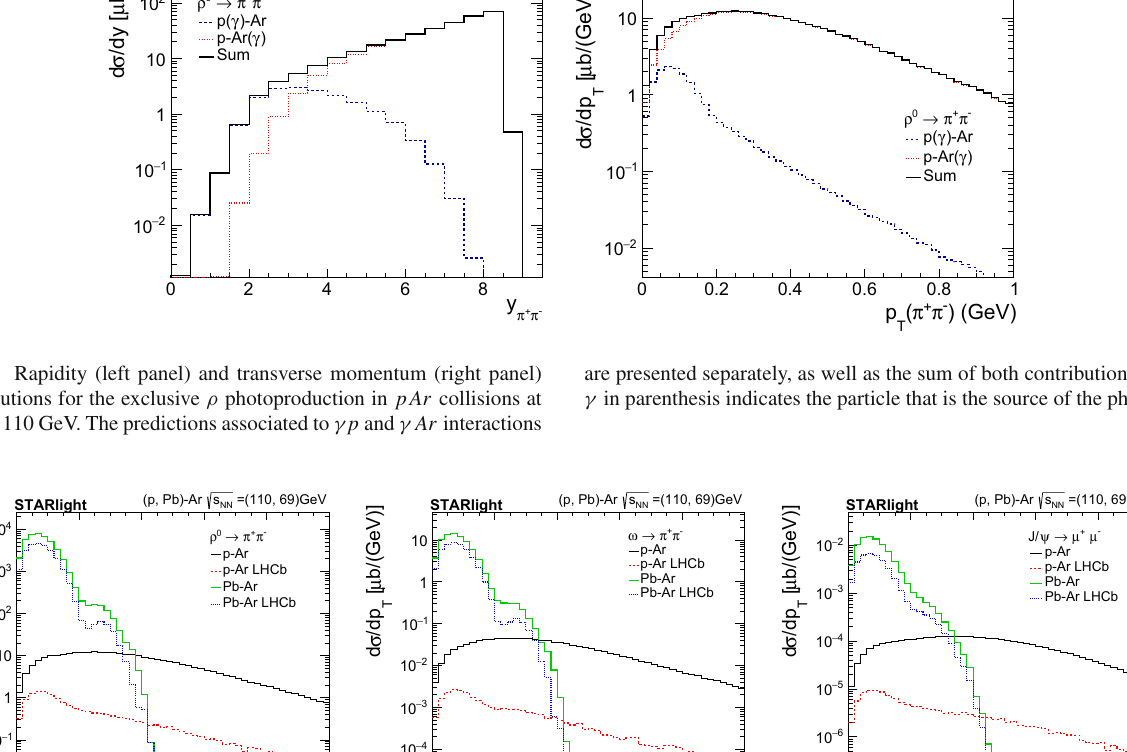
Fig. 3 Transverse momentum distributions for the exclusive vector meson photoproduction in pAr and PbAr collisions at respectively. The predictions obtained assuming the LHCb requirements are also presented for